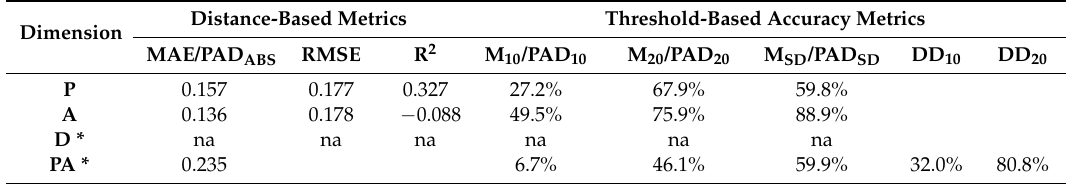
Table 7. Accuracy metrics fora reference mapping matrix applied on NAWL-NAWL